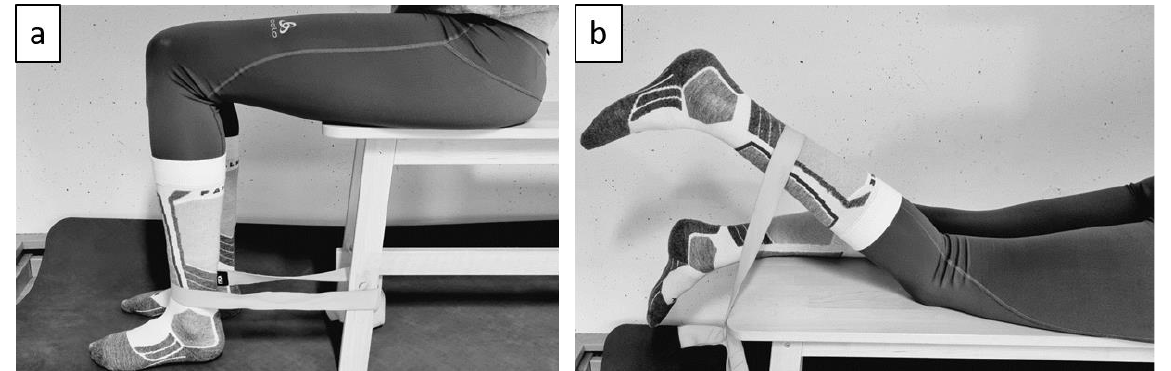
Figure 2. ( a ) Setup to record the MVC of the quadriceps. ( b ) Setup to measure the MVC of the ham-